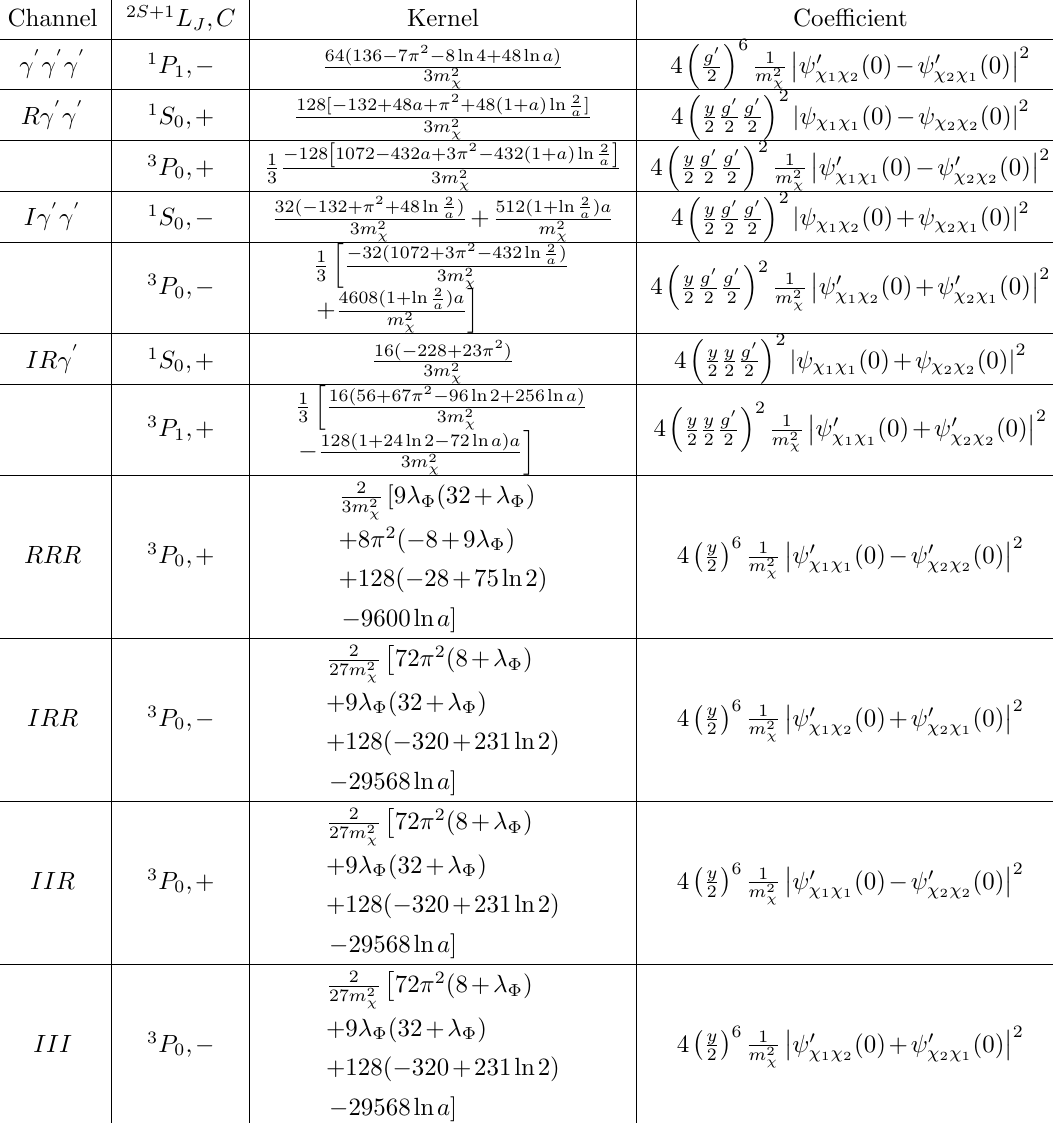
Table 4 . Three-body decay squared matrix elements, phase-space integrated, (cid:12)nal-state summed. Here, for abbreviation, we de(cid:12)ne g 0 = Q (cid:31) g . The \ LSJC " indicates the quantum numbers of the orbital angular momentum, total spin, total angular momentum, and C-parity. We still use m (cid:31) to replace the m (cid:31) as in the table 3, and since the three-body modes are not counted in the 1 ; 2 annihilation processes, we only show the results in the E ! m (cid:31)